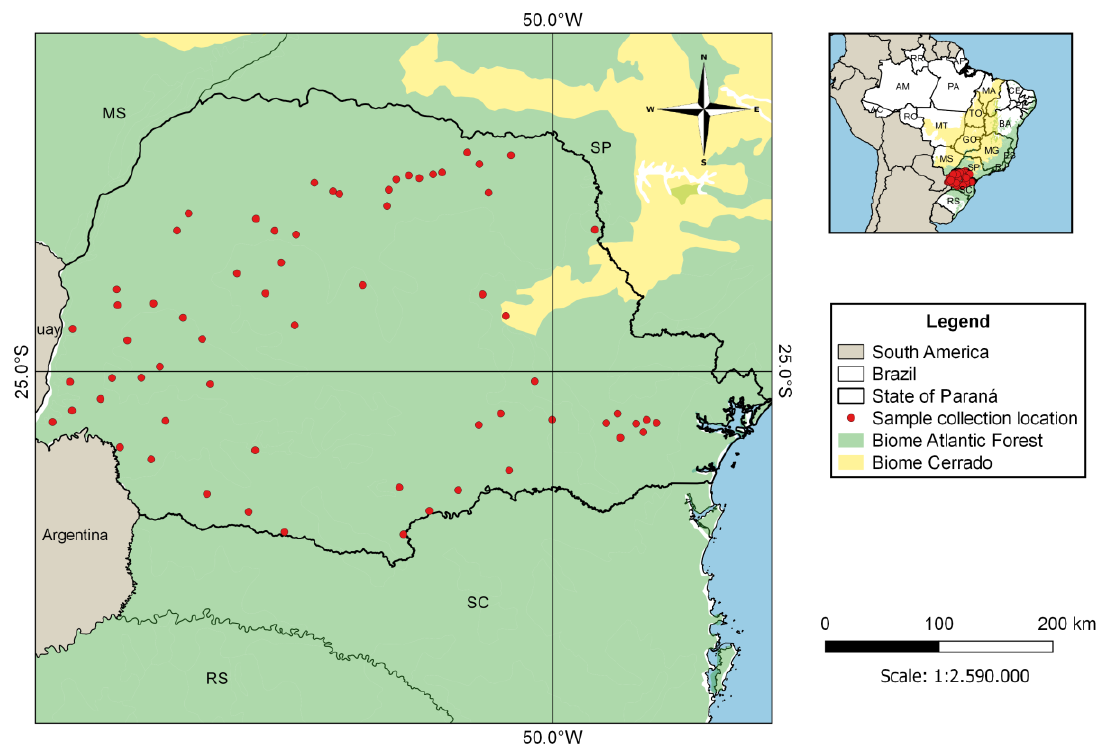
Figure 1. Location of municipalities in the State of Paraná, Brazil, where bat samples were collected.